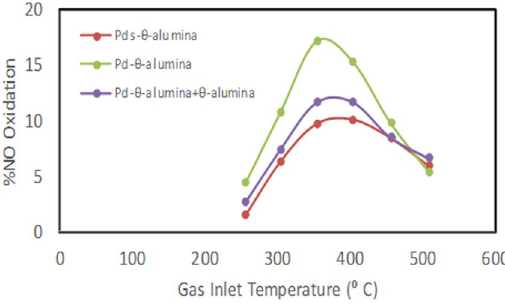
Figure 2. The NO oxidation light-off over Pd s - θ -alumina and Pd- θ -alumina employing 420 ppm NO + 5% O 2 . NO conversion over pure θ -Al